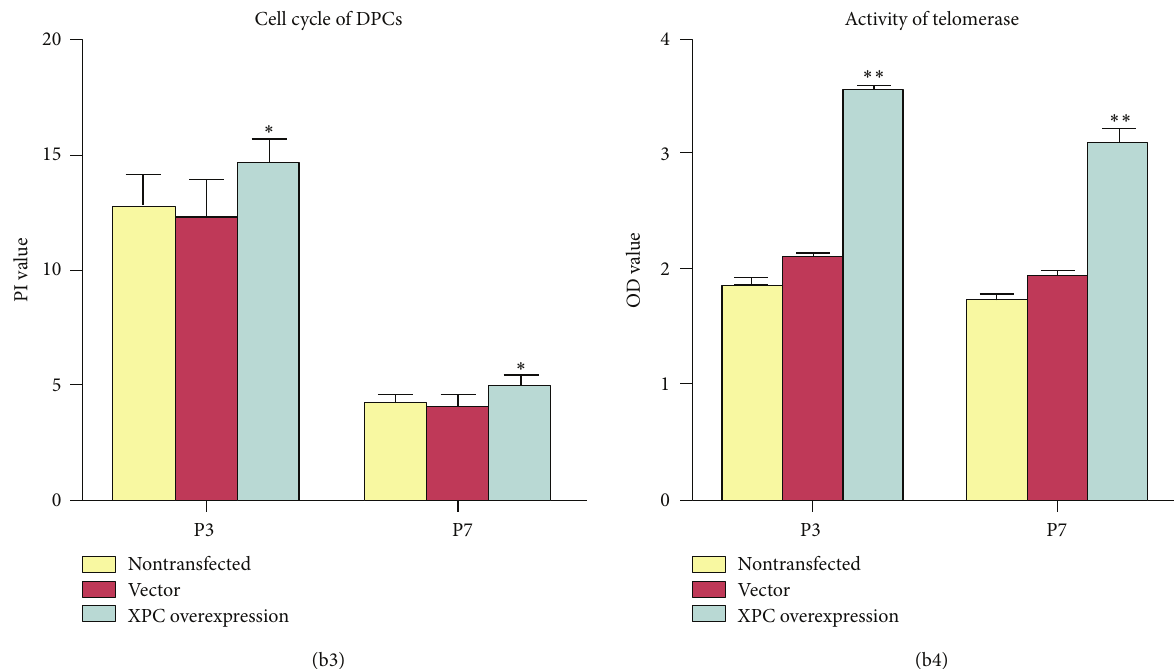
Figure 3: Effect of XPC on cell proliferation and apoptosis and cell cycle and senescence of DPCs with in vitro culture. CCK8 revealed that cell proliferation of transfected DPCs at both P3 and P7 was significantly enhanced (b1, ∗∗ 𝑝 < 0.001 ). The result of FACS (a1–a6) demonstrated that the cell number of transfected DPCs at P3 and P7 in G0/G1 was significantly downregulated compared with the vector groups; DPCs were arrested in G2/M and S phase. The percentage of PI = (S + G2/M) value (b3, ∗ 𝑝 < 0.05 ) and telomerase activity (b4, ∗∗ 𝑝 < 0.001 ) of transfected DPCs at both P3 and P7 was significantly upregulated, albeit the apoptosis rate was significantly downregulated (b2, ∗ 𝑝 < 0.05 ).